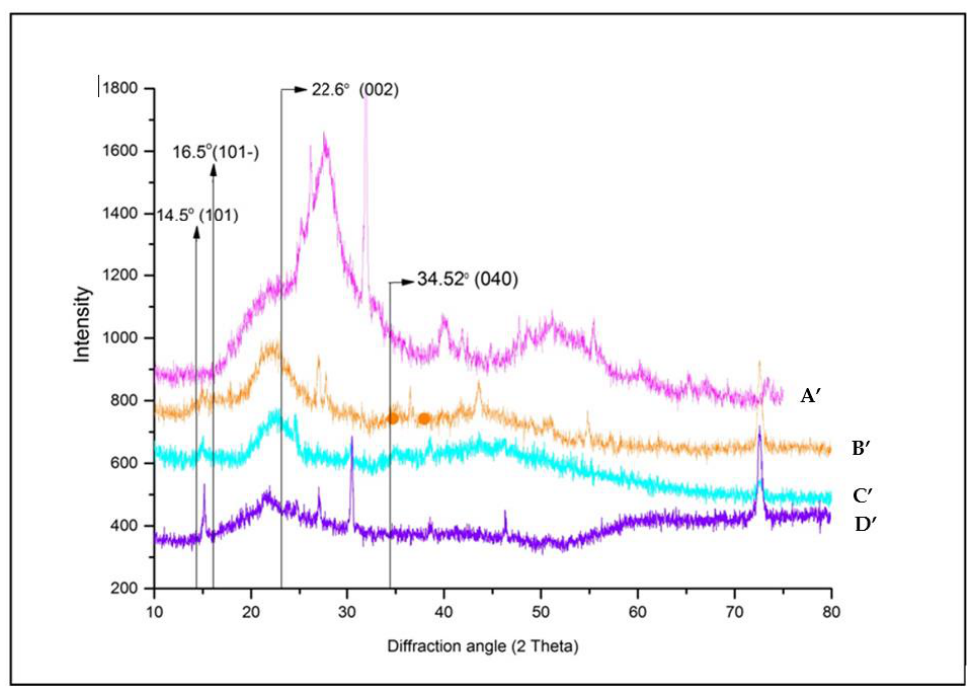
Figure 5. XRD diffractogram of degraded cedar wood samples (A’: 21st century, B’: 19th century, C’: 17th century, D’: 16th century). Table 3. Crystallinity indices values (CrI %) and crystallites seize: degraded and non-degraded wood samples.